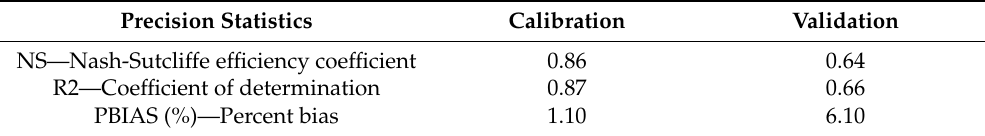
Table 5. Precision of the monthly streamflow simulation (calibration and